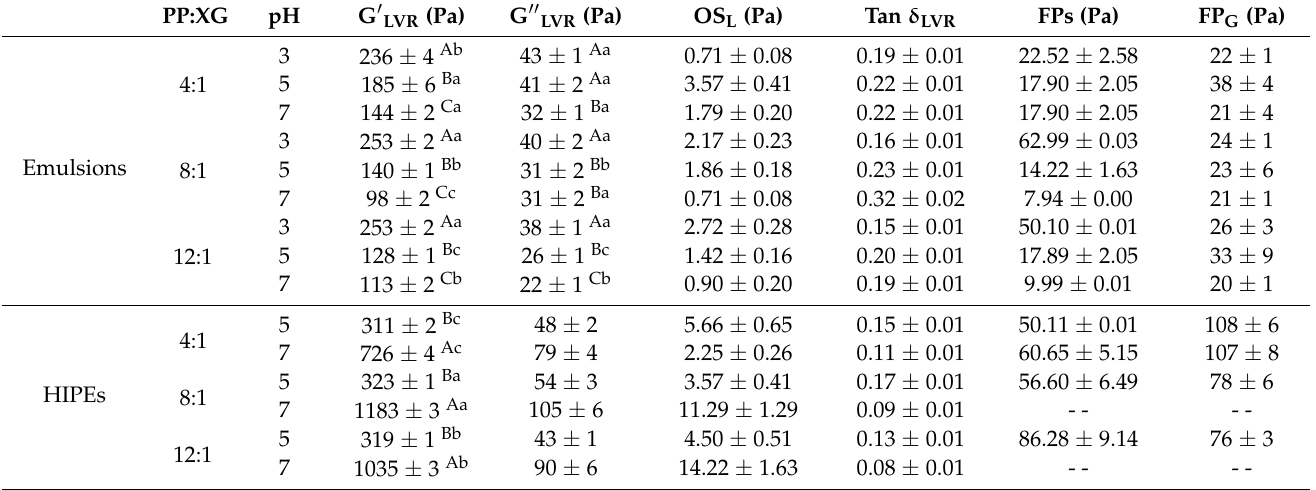
Table 3. Storage (G (cid:48) ) and loss modulus (G (cid:48)(cid:48) ), limiting value of oscillatory stress (OS L ), loss-tangent (tan δ ), flow-point stress (FP S ) and flow-point G (FP G ) for emulsions and High Internal Phase Emulsions (HIPEs) produced at different pea protein: xanthan gum ratios (PP:XG) and